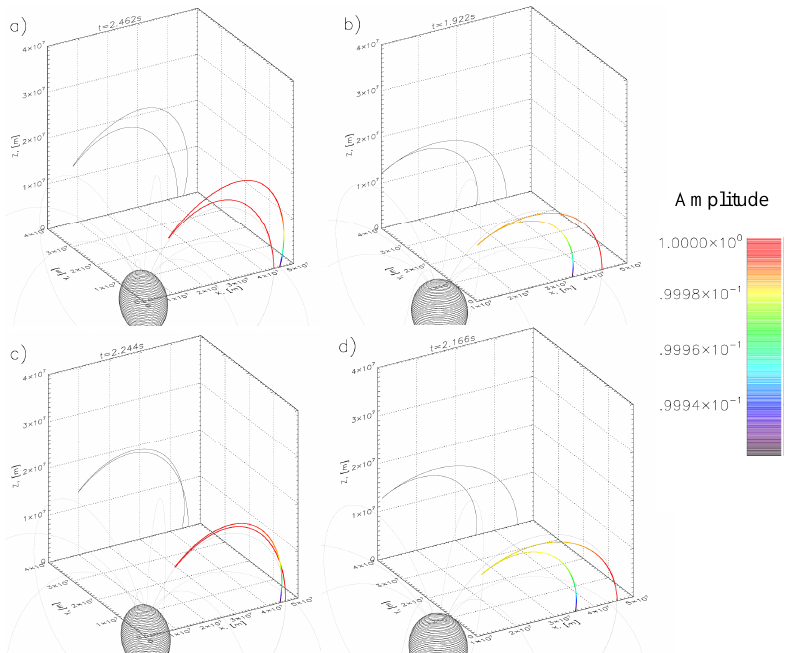
Figure 3. Sample trajectories of representative rays launched at L = 6 . 8 (upper panels) and L = 7 . 2 (lower panels), and reflected at L = 7 (left panels) and L = 5 . 5 (right panels). The ray’s frequency is ω = 0 . 4 (cid:127) e, 0 for rays a and c, and ω = 0 . 45 (cid:127) e, 0 for rays b and d. The ray’s time of travel t is indicated in each panel. Color corresponds to the ray’s amplitude (see colorbar), starting at the normalized value of 1 (red color) and being damped during their propagation back to the equator (blue color). The Earth is depicted in grey color. in the right column. Ray b is launched at L 0 = 6 . 8